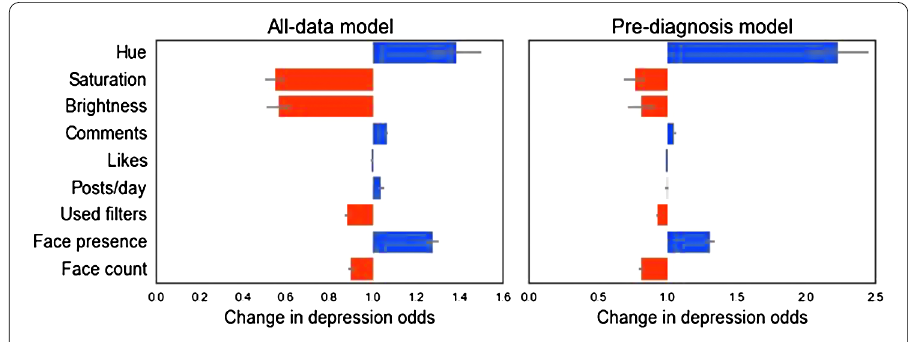
Figure 2 Magnitude and direction of regression coefficients in All-data ( N = 24,713) and Pre-diagnosis ( N = 18,513) models . X-axis values represent the adjustment in odds of an observation belonging to the target class, per unit increase of each predictive variable. Odds were generated by exponentiating logistic regression log-odds coefficients.